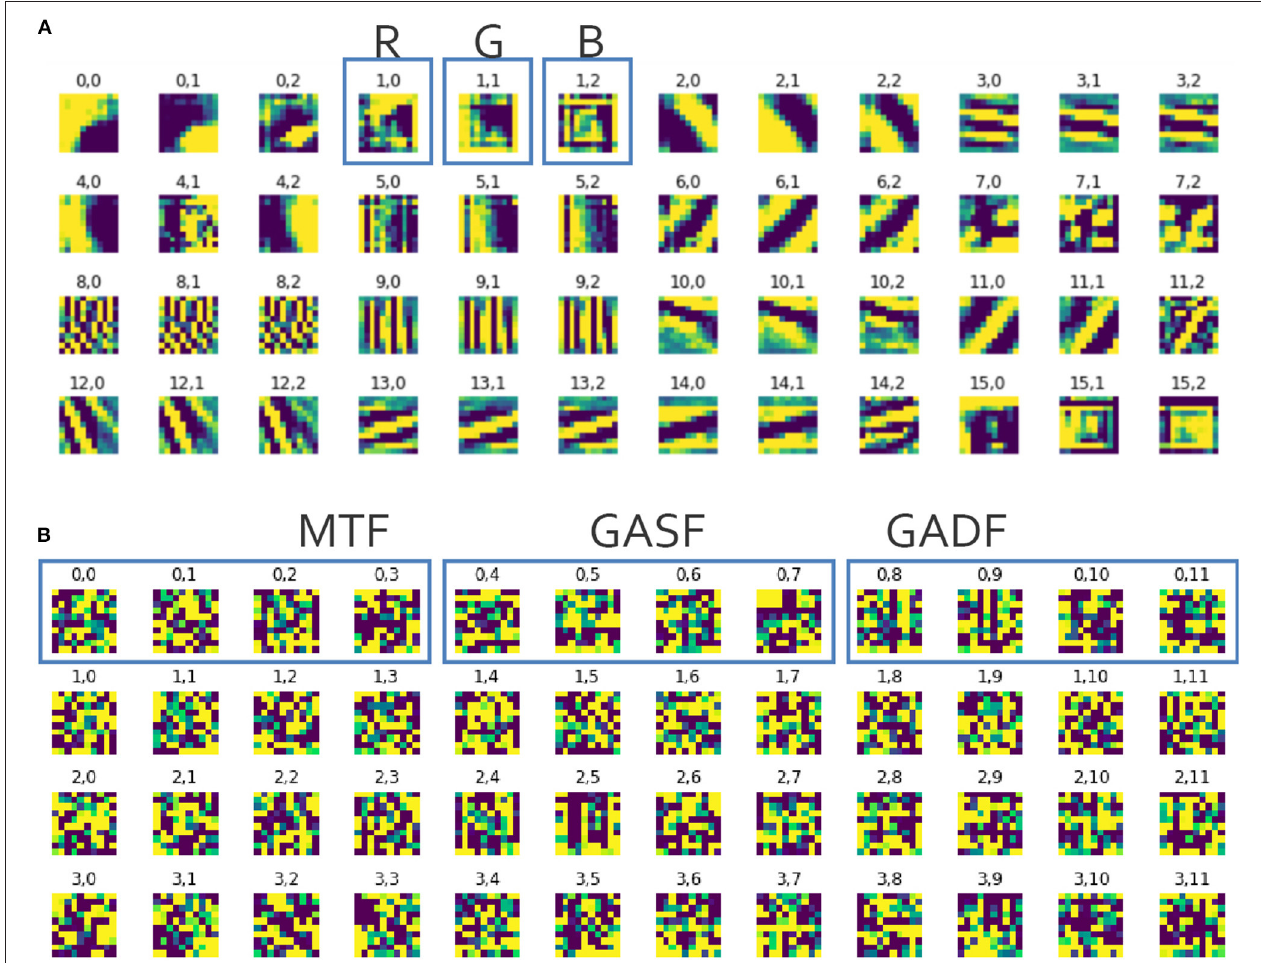
FIGURE 9 | Excerpt from the visualization of the filters learned by the first convolutional layer of (A) the AlexNet trained on an image data set of real objects (i.e., animals and fruit) where X.0-X.2 represent the RGB-channels, and (B) the SimpleNet trained on ITS features, where X.0-X.3 represent the MTF images, X.4-X.7 represent the GASF images and X.8-X.11 represent the GADF